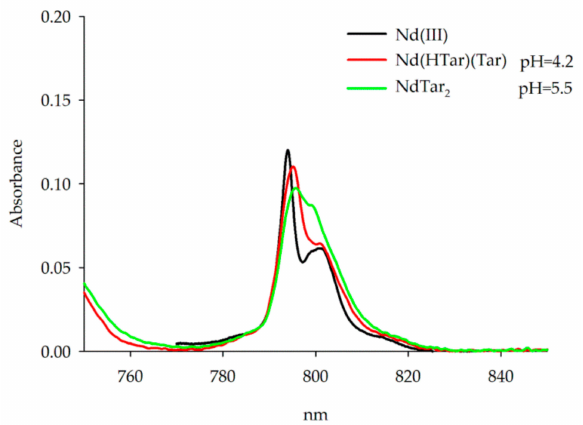
Figure 4. The absorption spectrum of Nd(III) ion in the system Nd(III) / Tar in the range of the transition 4 I 2 H 9 / 2 – 9 / 2